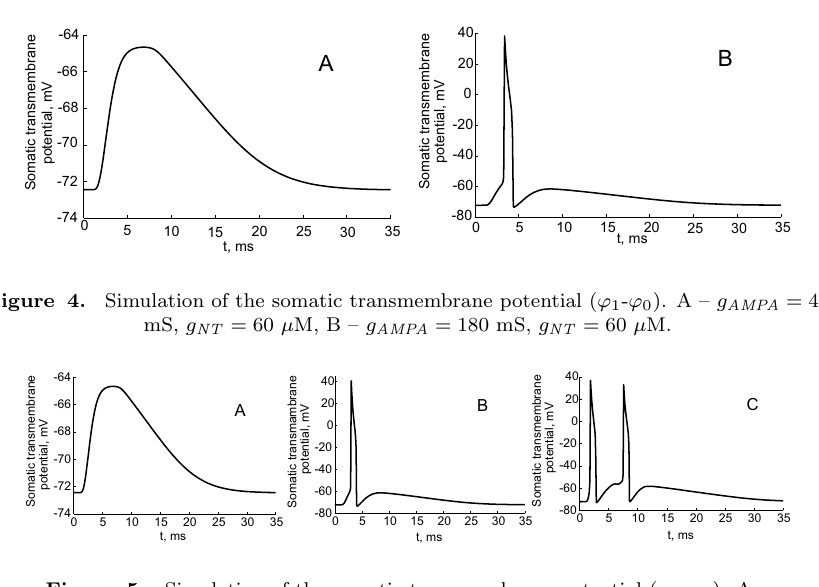
Figure 5. Simulation of the somatic transmembrane potential ( ϕ 1 - ϕ 0 ). A – g AMPA = 40 mS, g NT = 60 µ M, B – g AMPA = 25 mS, g NT = 450 µ M, C – g AMPA = 180 mS, g NT = 450 µ